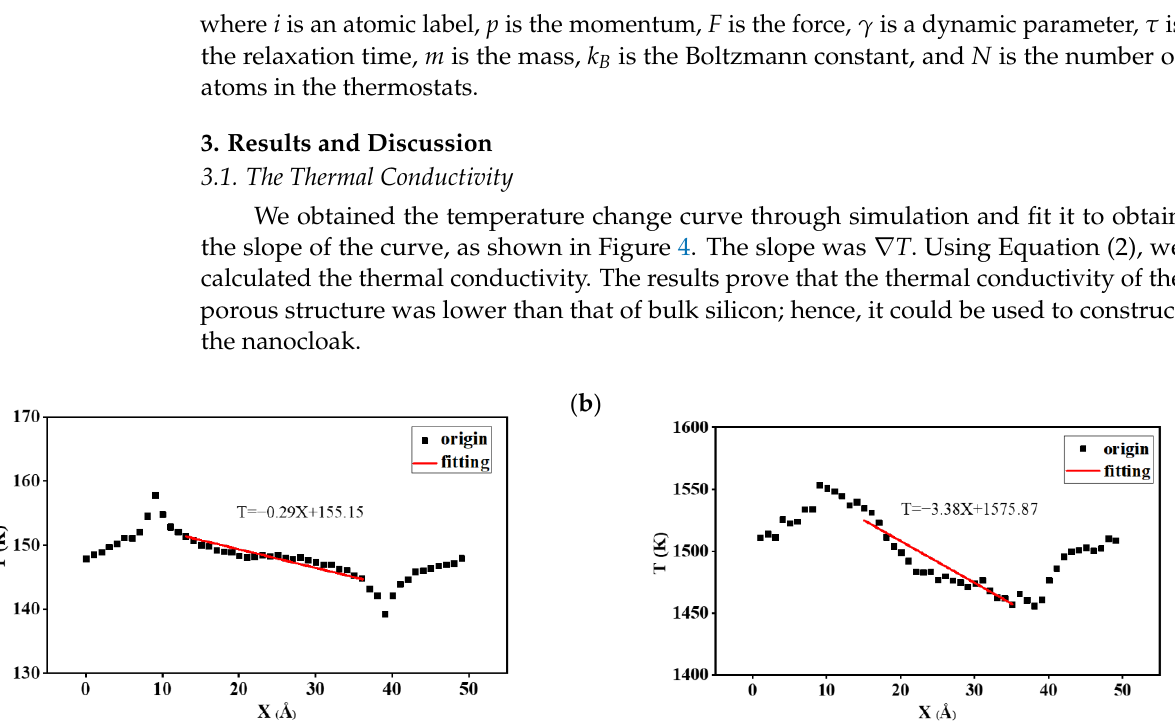
Figure 5. The RTC with different structures at 600 ps. To prove the occurrence of the cloaking phenomenon, the heat flux and temperature distribution of the crystalline film and the nanocloak at 600 ps are plotted in Figure 6. In the simulation process, we calculated the heat flux and temperature of a single atom; how- ever, we do not care about the state of a single atom but the state of the whole system. Therefore, we first divided the whole system into 40 small blocks, and then calculated the average heat flux and average temperature in each small block. By analyzing the heat flux distribution, we can clearly see the cloaking phenomenon. The heat flux of the whole func- tional region of the thermal cloak was kept extremely low, and the heat flux was spread 1